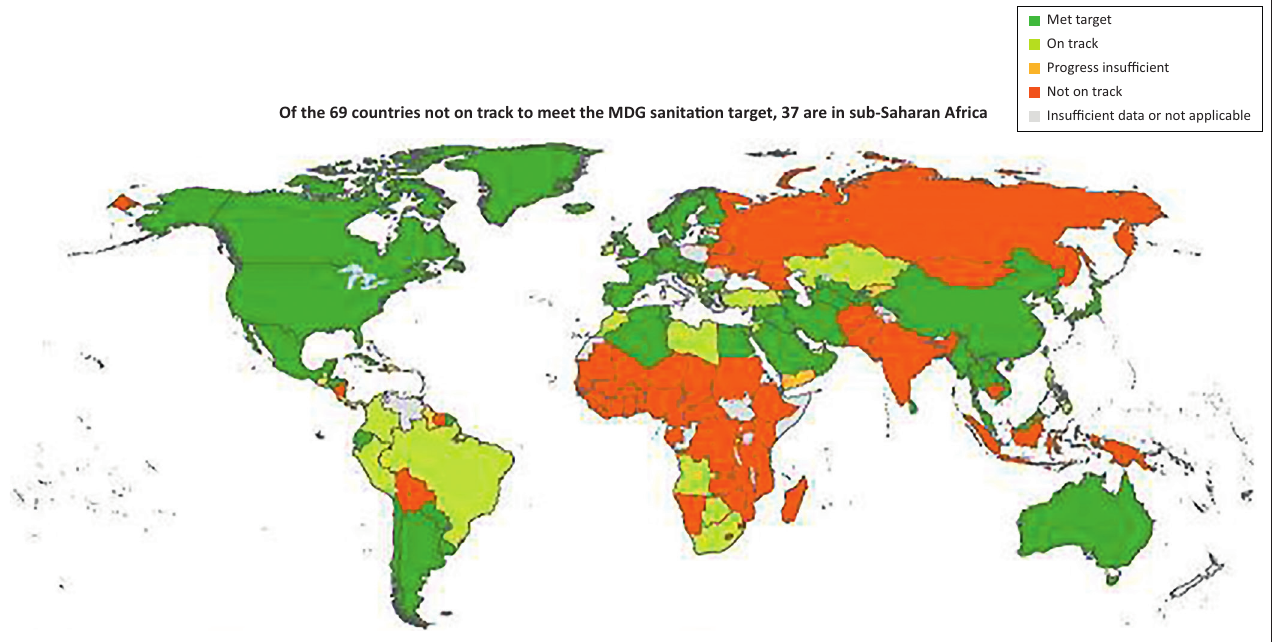
FIGURE 1: Progress towards Millennium Development Goals target.